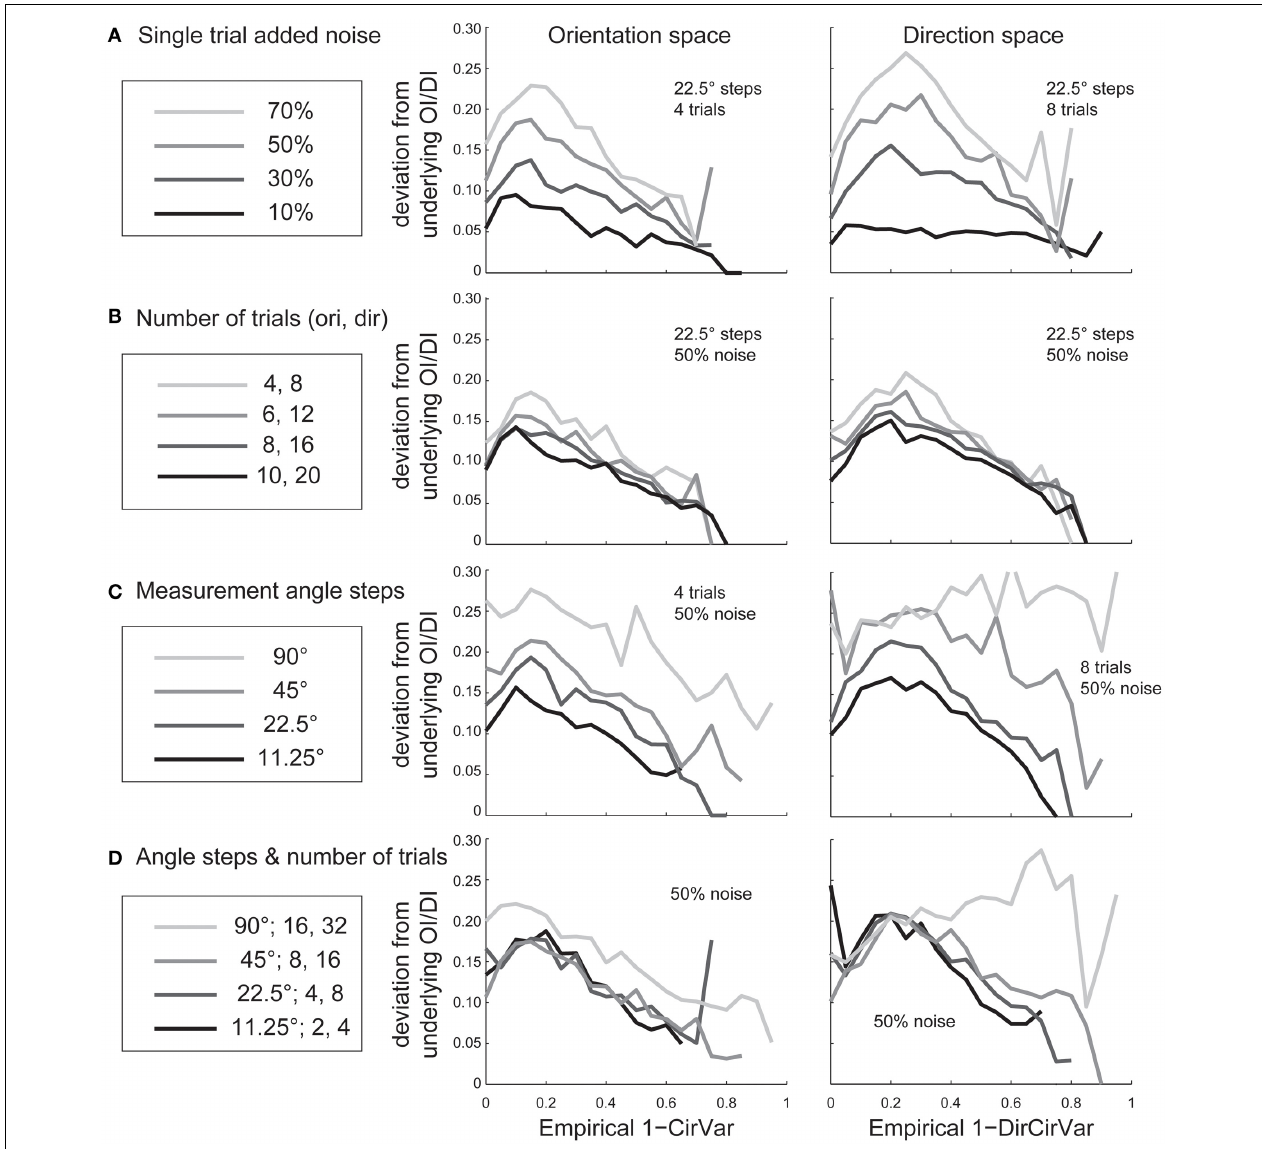
FIGURE 6 | The dependence of error in identifying the true OI on neural noise and stimulus sampling. On the Y axis of all plots is the average deviation between the “true” OI (or DI ) and the “best guess” of OI (or DI ) based on the empirical 1- CirVar (or 1- DirCirVar ). (A) Dependence of error on single trial noise as a percentage of the maximum response rate to the